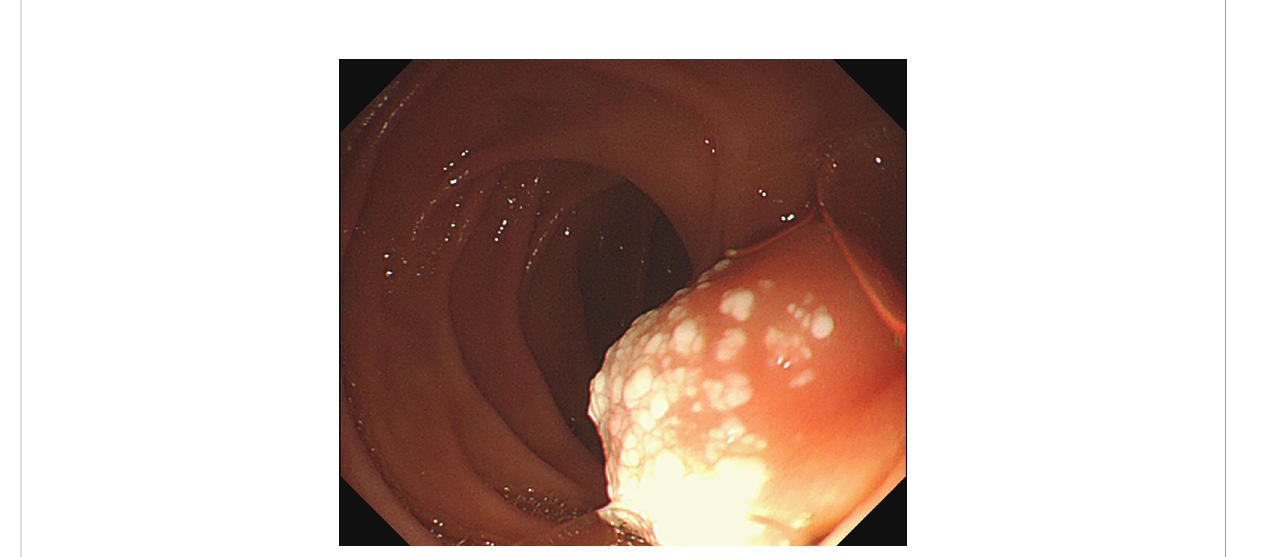
FIGURE 4 Mucosal prominence with white spots was the endoscopic appearance of the duodenal